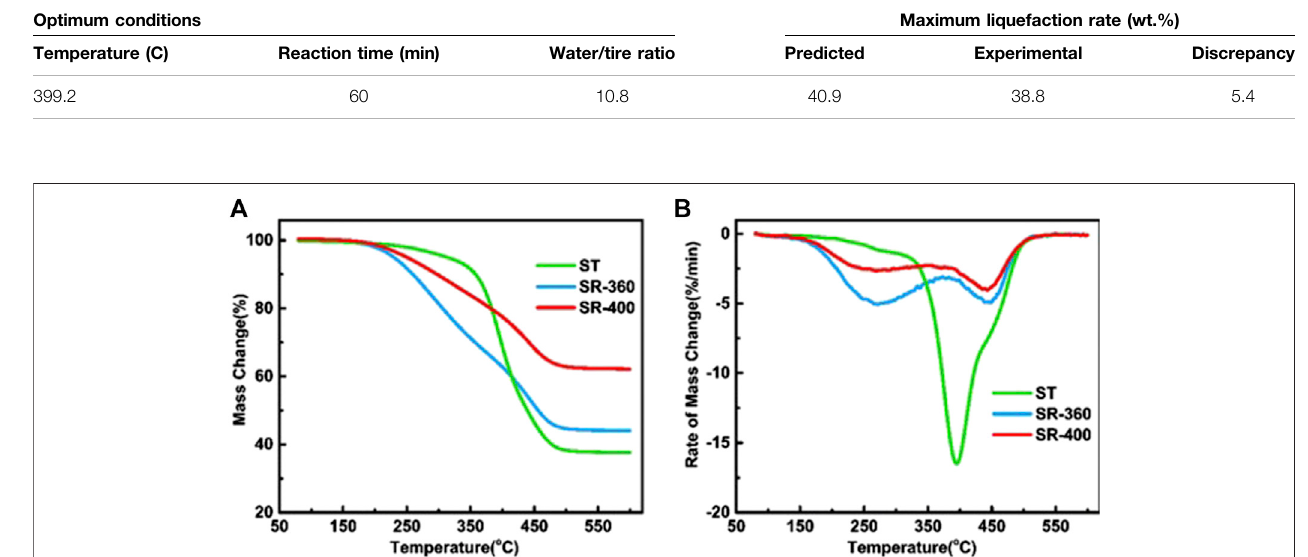
TABLE 2 | Optimum operating conditions and liquefaction